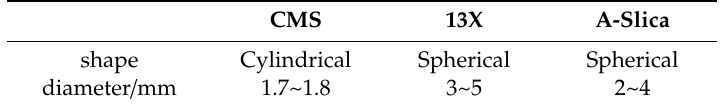
Table 2. Shape and size of adsorbent particles.